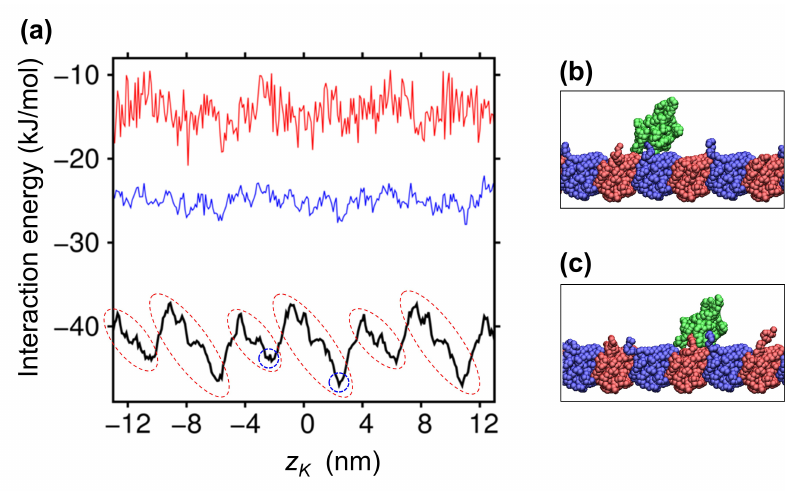
Figure 3. ( a ) The average interaction energy between KIF1A and the MT is shown as a function of z K (black). Broken red circles indicates the slopes toward the plus-end of the MT. Average interaction energies at greater salt strengths are also displayed (blue: 150 mM ( λ = 0.78); red: 200 mM ( λ = 0.67)). ( b , c ) Snapshot structures at the energy minima, located at z K ∼ − 2 nm ( b ), and at z K ∼ 2 nm ( c ), which are designated by broken blue circles in ( a ).